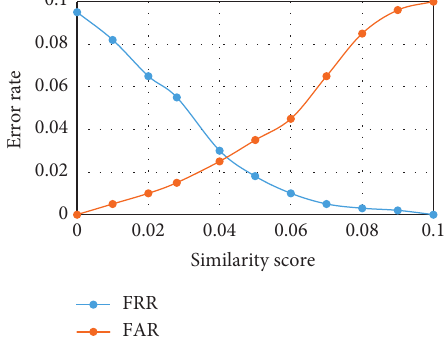
00.020.040.060.080.1